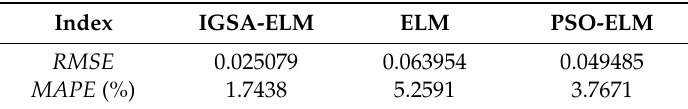
Table 7. Error analysis of the compared